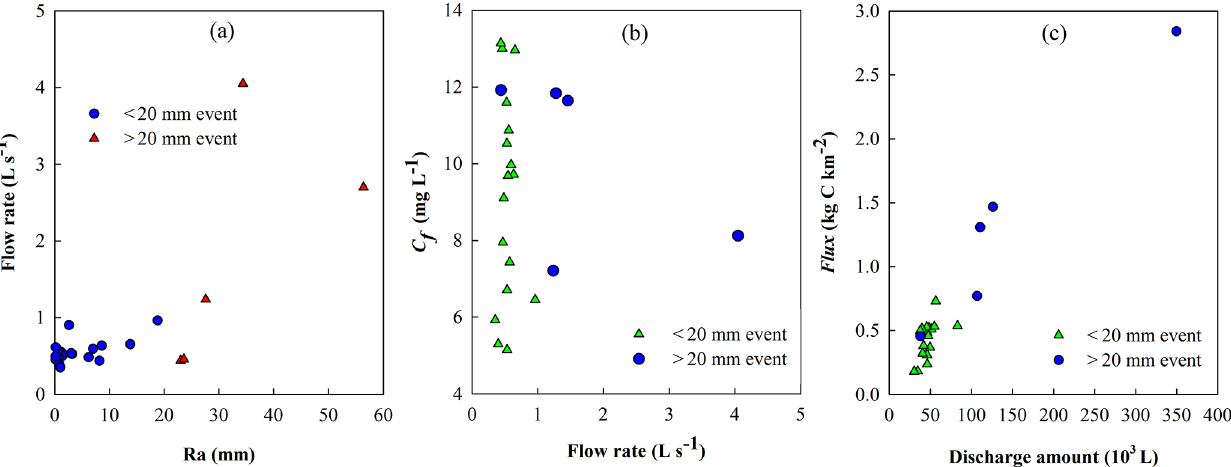
Figure 4. Relationships between R a (rainfall amount) and flow rate (a) , C f (flow-weighted mean concentration) and flow rate (b) , and flux and total discharge (c) for sampled rainfall events during the monitoring period (June–September